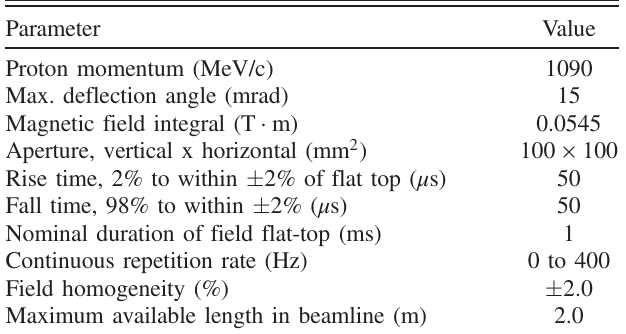
TABLE I. Specifications for the UCN kicker magnet